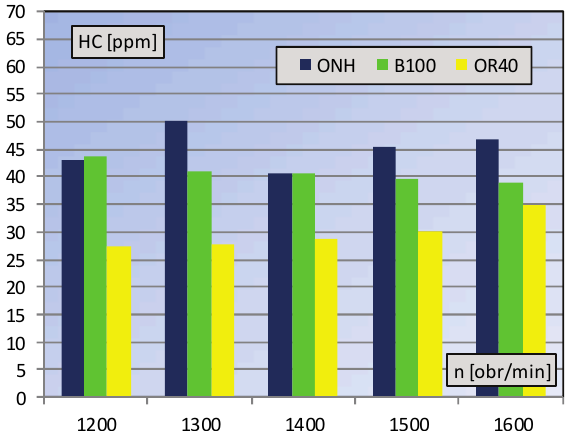
Fig. 7. Concentration of hydrocarbons HC in exhaust gases for test engine performance characteristics